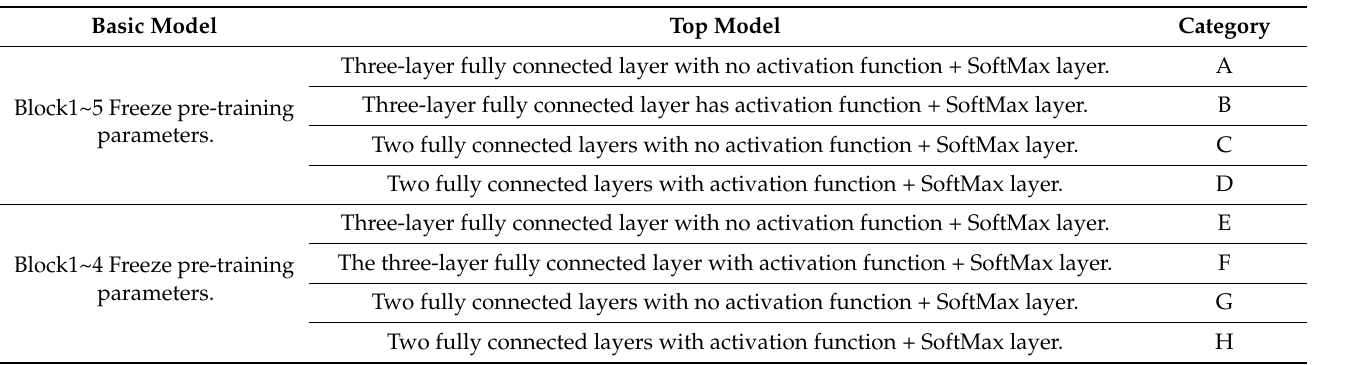
Table 1. Network